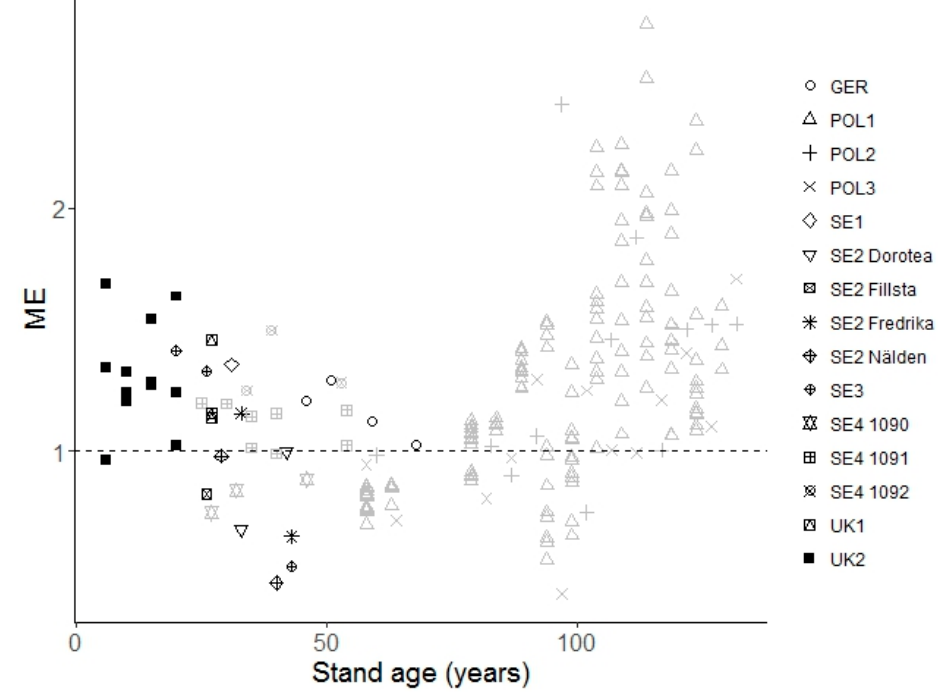
Figure 5. Mixing effect ME against stand age with different symbols that mark the different study sites (grey color indicates where growth of pure spruce was estimated).